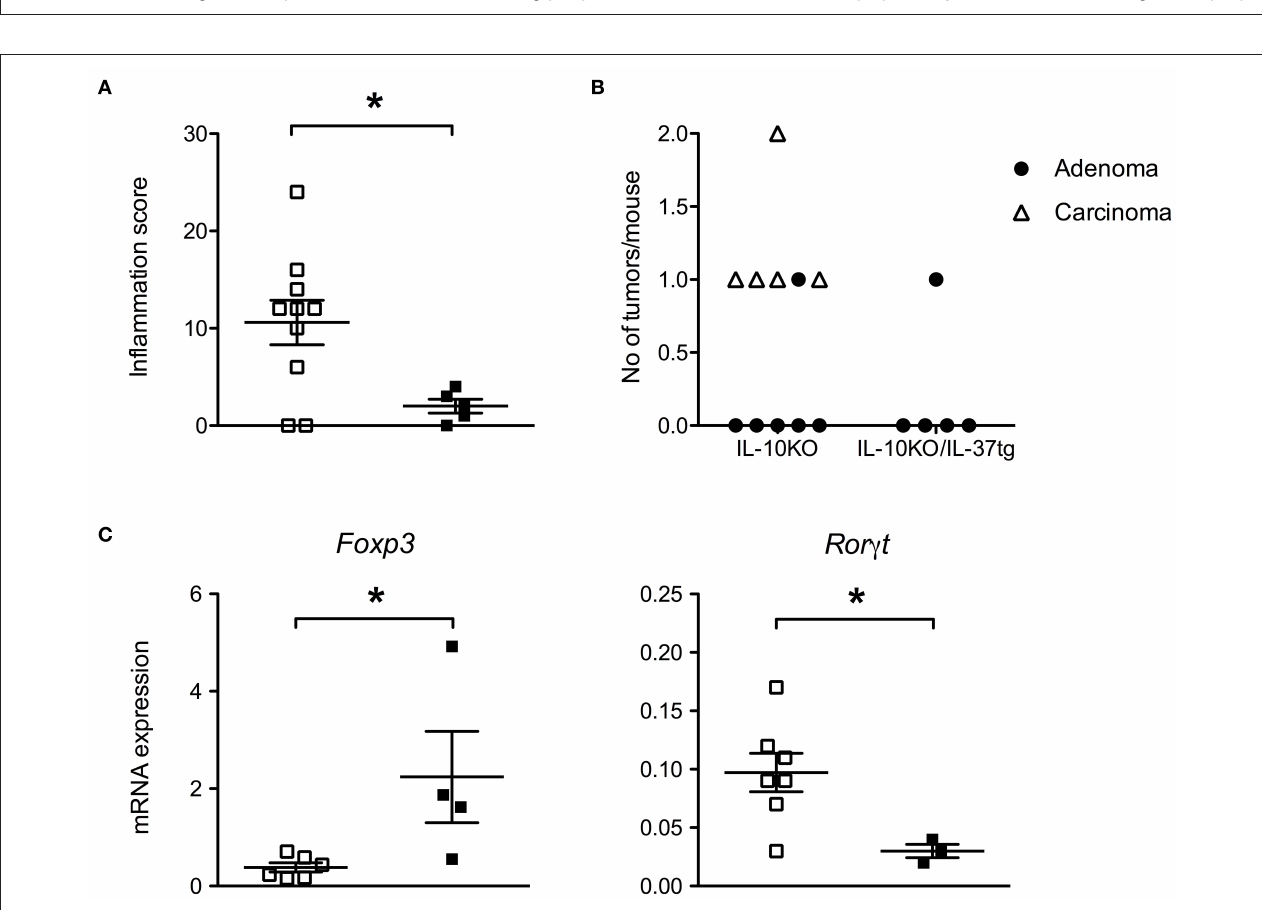
FIGURE 4 | paraffin. Cross-sections of full-length bowel specimen underwent HE-staining (A–F) . (C) Ulceration and high-grade inflammation of IL-10KO mouse. (D) Low-grade infiltration IL-10KO/IL-37tg. (E) Regenerative Hyperplasia with high-grade inflammation in IL-10KO mice. (F) Mild- infiltration in IL-10KO/IL-37tg mouse. Cross-sections of full-length bowel specimen underwent Ki-67-staining (G,H) . PT2 carcinoma in IL-10KO mouse (G,I) . Healthy tissue of IL-10KO/IL-37tg mouse (H,J) .